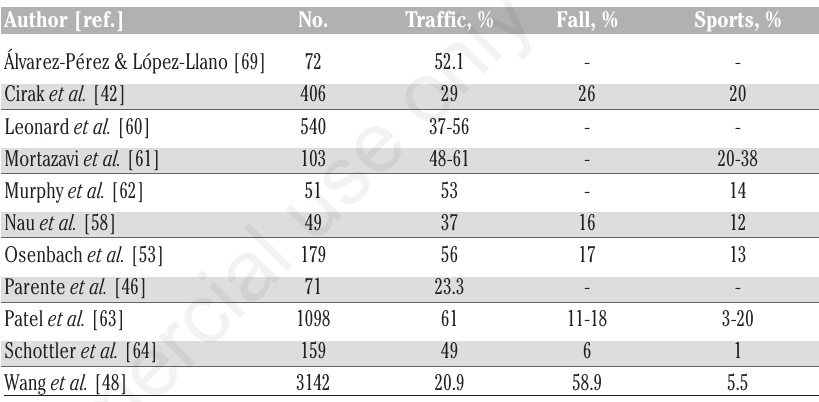
Table 2. Literature causes of spine